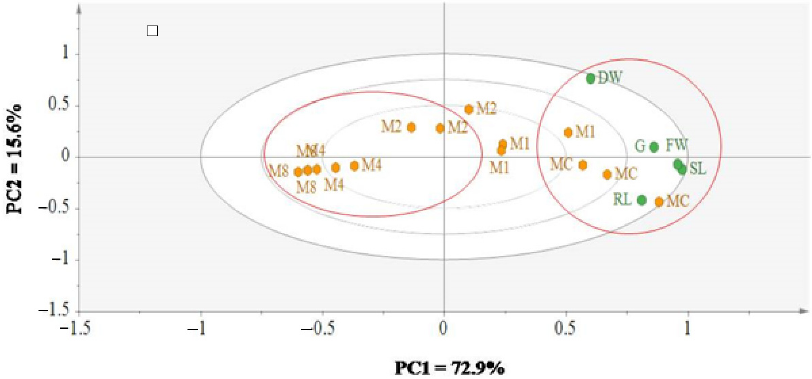
Figure 7. Effect of various concentrations of H. persicum aqueous extract on seed germination, seedling growth, and biochemical features in wheat. WC = Wheat control; W1 = 1% concentration; W2 = 2% concentration; W4 = 4% concentration; W8 = 8% concentration; TC = Total chlorophyll; CA = Chlorophyll a; CB = chlorophyll b; G = Germination percentage; DW = Dry weight; FW = Fresh weight; SL = Shoot length; RL = Root length; P = Proline; C = Carbohydrates.